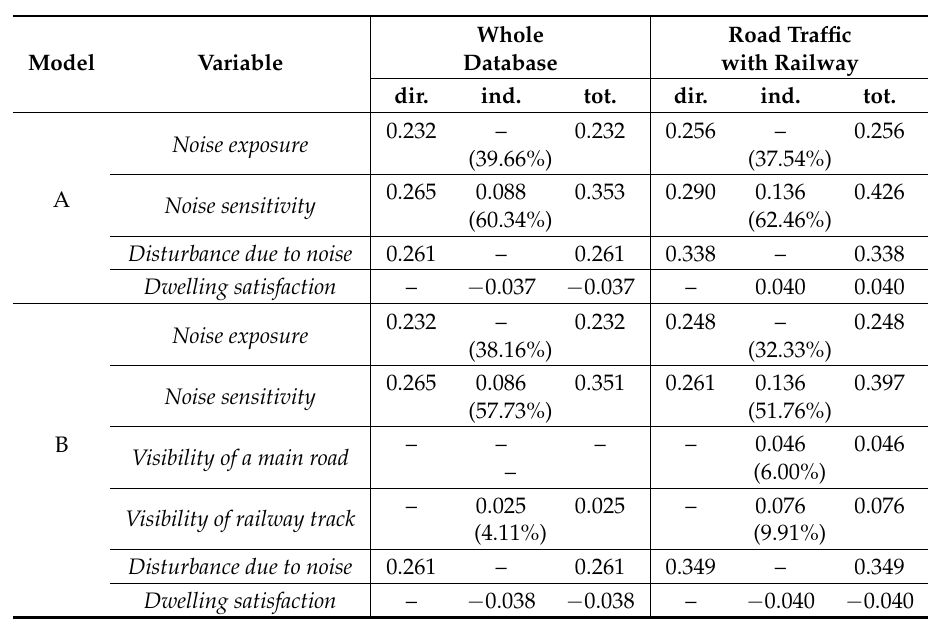
Table 8. Direct (dir.), indirect (ind.) and total (tot.) effects of all variables affecting noise annoyance due to railway noise in Models A and B. Contributions of exogenous variables are given in percentage between